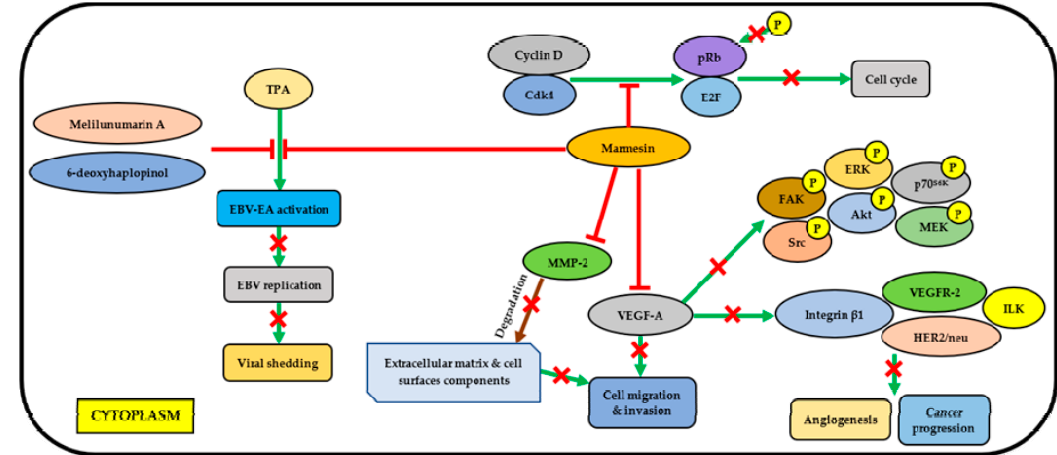
Figure 1. The mechanisms of cytotoxic/chemopreventive activity exhibited by marmesin. TPA, 12- O -tetradecanoylphorbol-13-acetate; EBV-EA, Epstein-Barr virus early antigen; Cdk, cyclin-dependent kinase; pRb, retinoblastoma protein; E2F, transcription factor E2F; P, phosphate; MMP-2, matrix metalloproteinase-2; VEGF-A, vascular endothelial growth factor A; FAK, focal adhesion kinase; Src, proto-oncogene tyrosine-protein kinase; ERK, extracellular signal-regulated kinase; Akt, protein kinase B; p70S6K, ribosomal protein S6 kinase beta-1; MEK, mitogen-activated protein kinase kinase; VEGFR-2, vascular endothelial growth factor receptor-2; ILK, integrin-linked kinase; HER2/neu, human epidermal growth factor receptor 2.